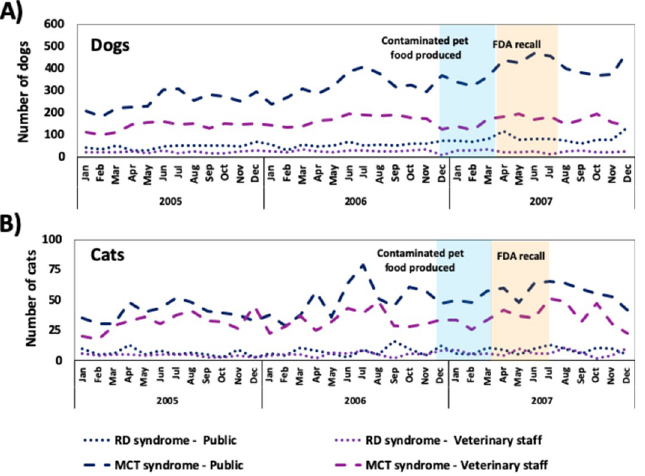
Fig 4. Number of dogs and cats with urinary and renal failure syndromes reported to the APCC during a toxicological consult call from 2005 to 2007, inclusive, stratified by call source. (A) Number of dogs. (B) Number of